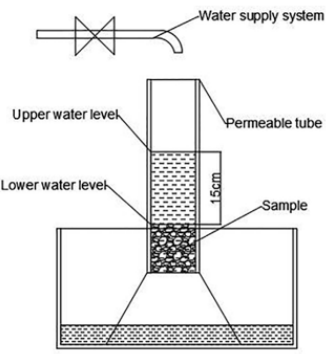
Figure 3. Falling-head permeability test device [1].